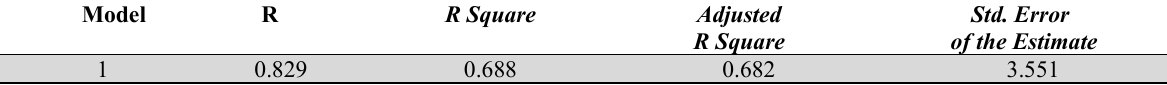
Results of Test on the Coefficient of Determination of Sub-Structural I Equation Model